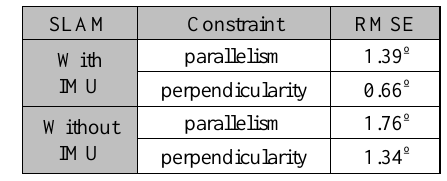
Table 4. RMSE of angles’ errors for parallelism